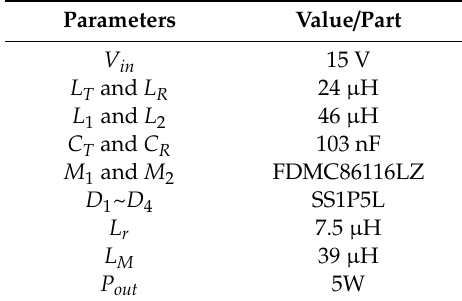
Figure 12. Experimental waveforms in the critical coupling condition.